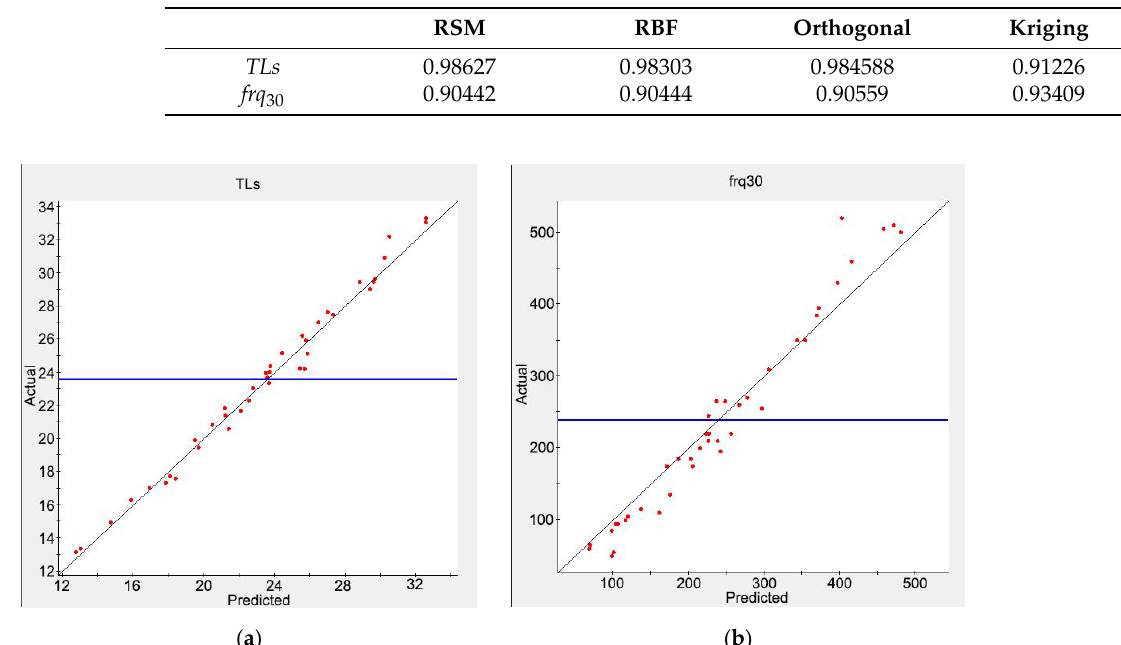
Figure 15. Scatter plots of the approximate models : ( a ) TLs and ( b ) frq 30